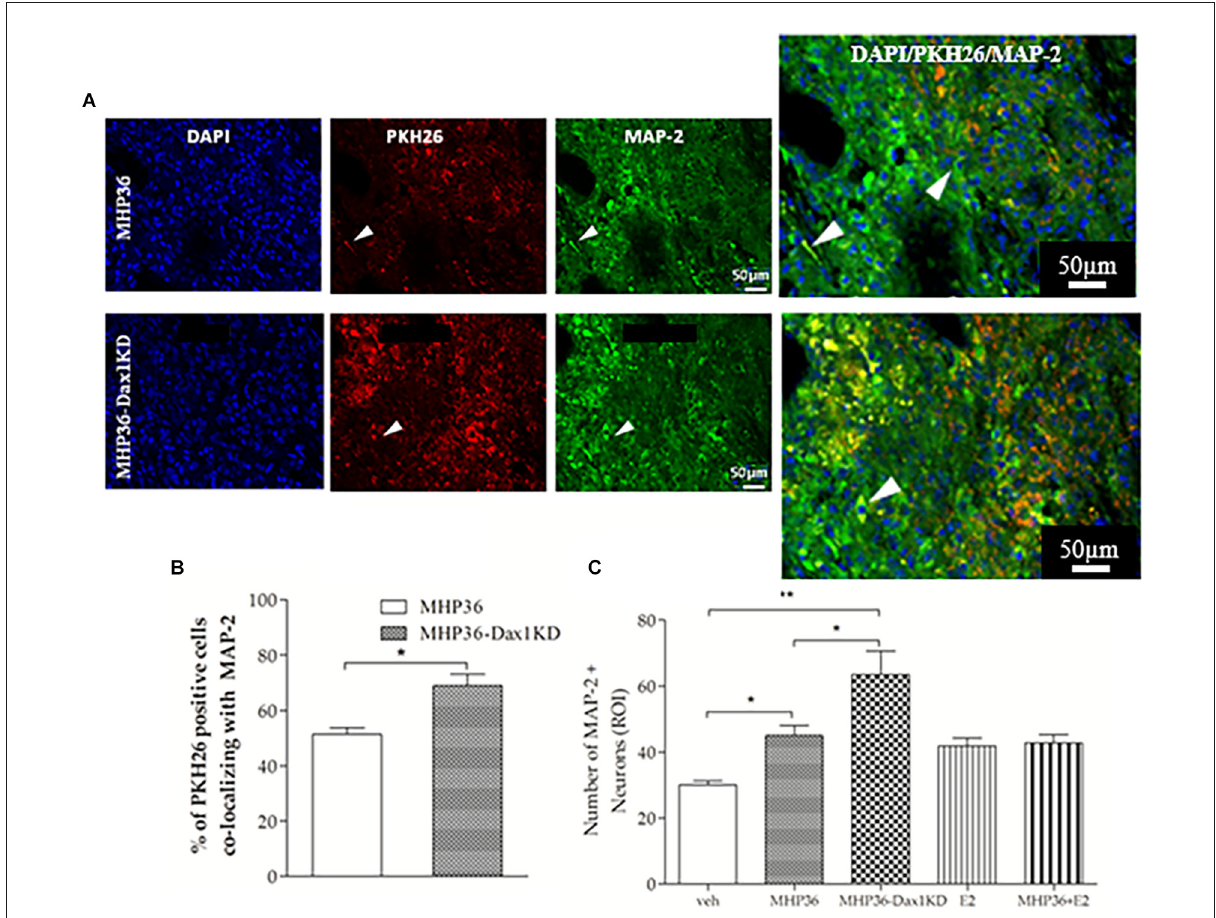
FIGURE7 MHP36-Dax1KD grafts promoted neuronal differentiation in the host brain. (A) Peri-infarct cortex in mice receiving the PKH26 labeled MHP36 and MHP36-Dax1KDstainedwithMAP-2(scalebar=50 µ m,Bregma:-0.3 ± 0.10mm),withco-localizationshowninenlargedimages. (B) Percentage of PKH26 positive cells co-localizing with MAP-2 in the MHP36 and MHP36-Dax1KD grafted animals. (C) Number of MAP-2 stained neurons across all groups (* p < 0.05, ** p < 0.01; n = 3 all groups).